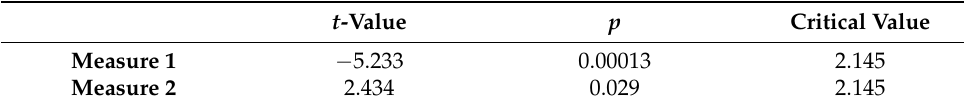
Table 10. Obtained t -test